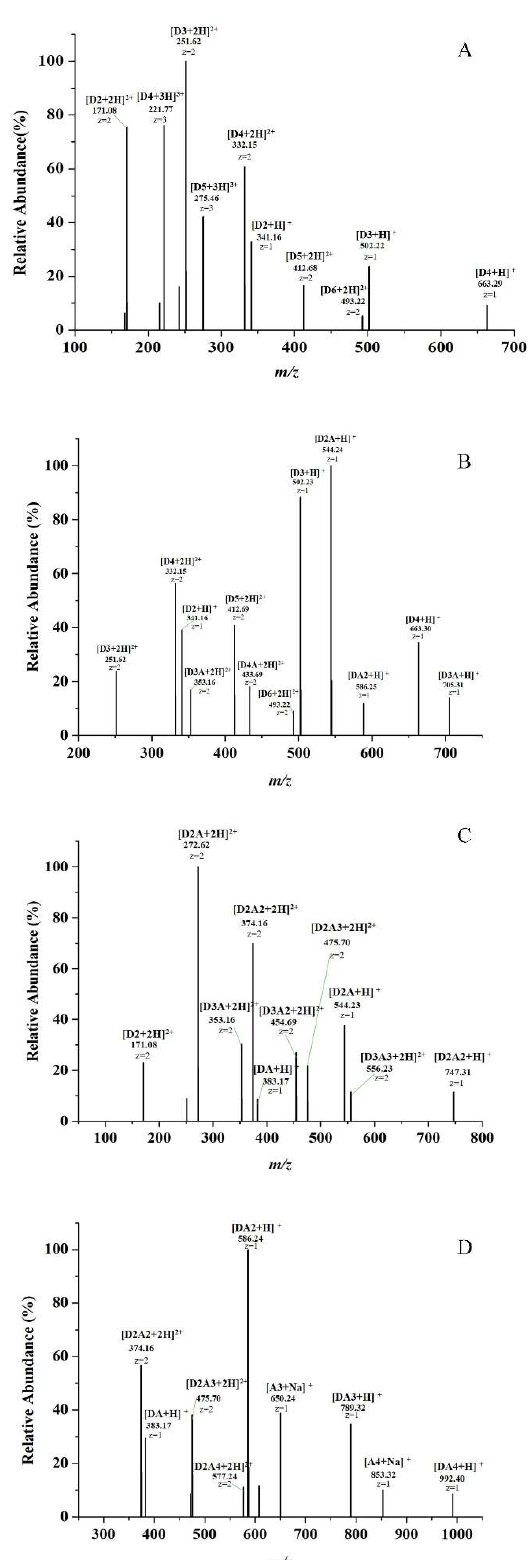
Figure 2. Mass spectrum analysis of the four prepared COSs with different DAs. ( A ) The positive-ion mode ESI-MS spectrum of COS with DA = 0%, ( B ) The positive-ion mode ESI-MS spectrum of COS with DA = 12%, ( C ) The positive-ion mode ESI-MS spectrum of COS with DA = 50%, ( D ) The positive-ion mode ESI-MS spectrum of COS with DA = 85%. The numbers in the figure only represent the number of monosaccharide